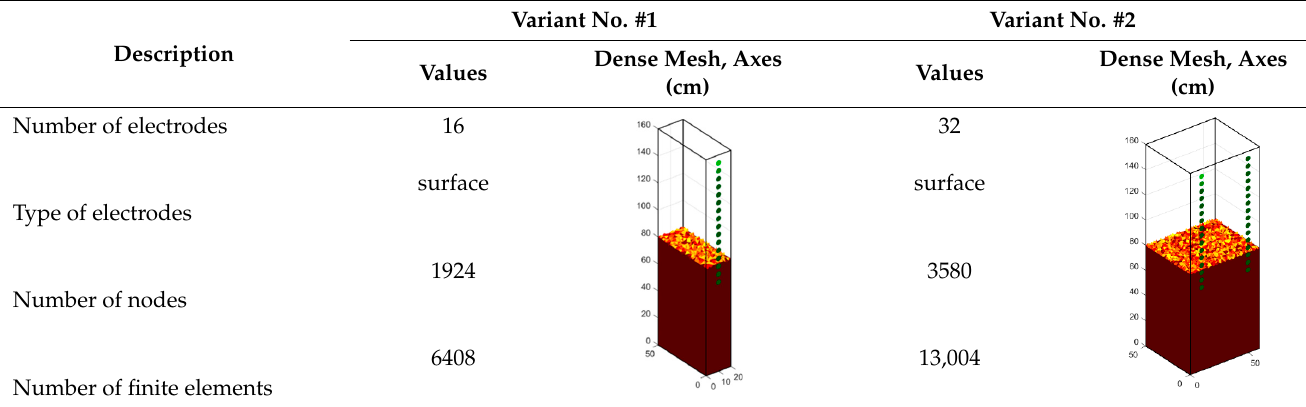
Table 3. Parameters of the finite element mesh—variants No. #1 and #2. Description